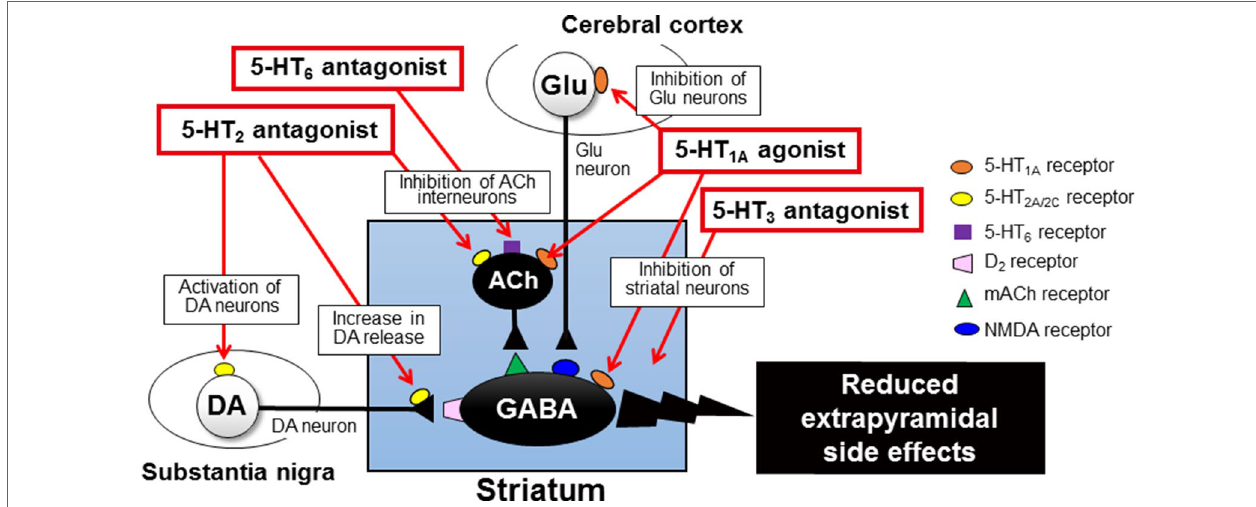
FIGURE 5 | Mechanisms underlying serotonergic modulation of antipsychotic-induced extrapyramidal side effects (EPS). Activation of 5-HT 1A receptors, especially postsynaptic 5-HT 1A receptors in the striatum and cerebral cortex, alleviates antipsychotic-induced EPS. Blockade of 5-HT 2 receptors on nigral dopamine neurons and their nerve terminals in the striatum can relieve the negative serotonergic regulation and thereby can increase the dopaminergic activities, which contributes to EPS reduction. Similarly, blockade of 5-HT 3 and 5-HT 6 receptors attenuates antipsychotic-induced EPS possibly via acting in the striatum. This figure is quoted and arranged from Biol. Pharm. Bull. 36, 1396,